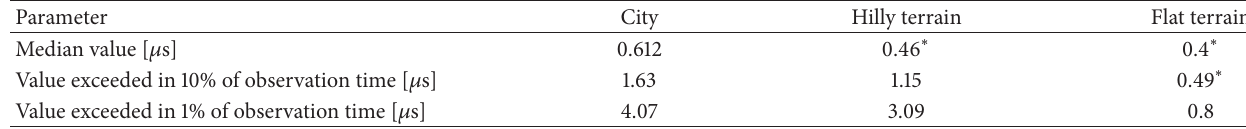
Table 2: Characteristic values of rms delay spread for UHF narrowband channels.